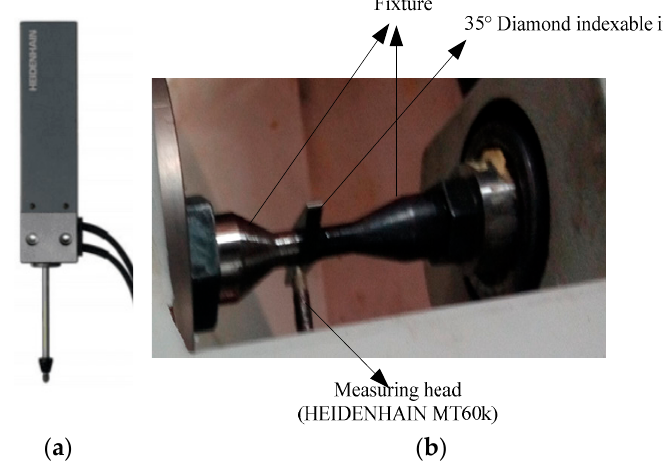
Figure 9. Dimension measurement diagram. ( a ) The displacement sensor. ( b ) Actual measurement diagram.